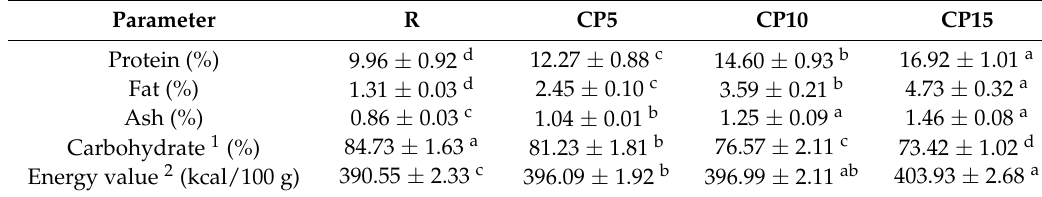
Table 1. Nutritional value of pasta with cricket powder